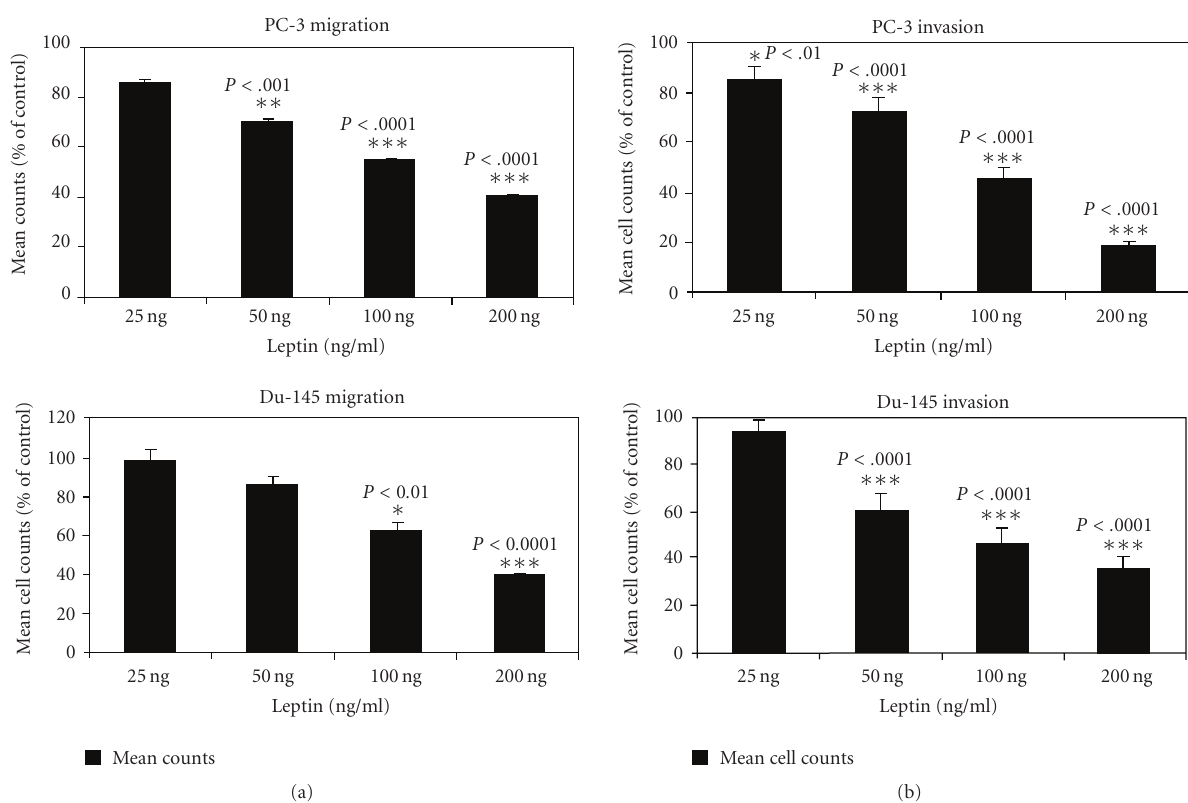
Figure 1: Cellular invasion and migration of androgen-resistant prostate cancer cells are attenuated by leptin . PC-3 and DU-145 cells were suspended in basal medium supplemented with 2% FBS, and 0.02% BSA, incubated with various concentrations of leptin, and plated onto the upper surface of the Transwell membrane inserts. For invasion studies, Matrigel was added to the upper surface of the Transwell membrane and allowed to solidify in a sterile environment for 24 hours. After 10 hours of incubation at 37 ◦ C in a CO 2 incubator, cellular invasion (a) and migration (b) were measured by counting the cells that had migrated to the lower surface of the membrane. Values represent the mean ± S.E. of triplicate samples of a representative